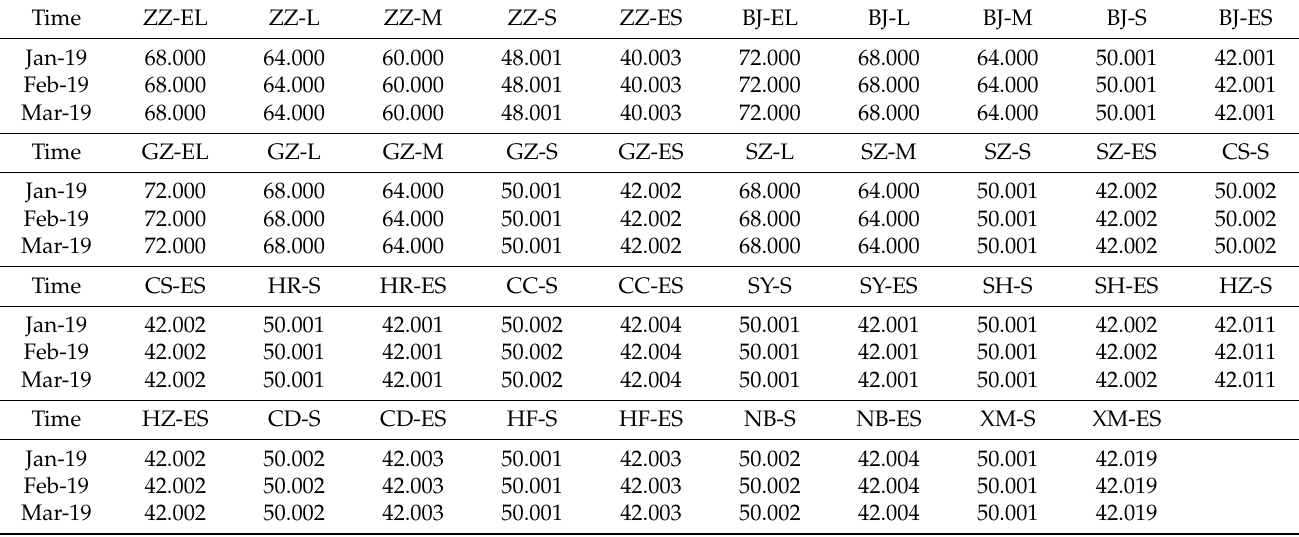
Table 7. The predicted value of each specification price in the ZZ group (CNY per kg).